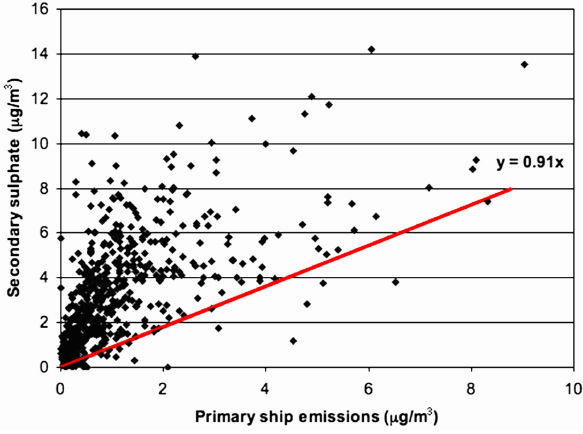
Figure 11. Correlation plot between the contributions from sec- ondary sulfate and from primary particulate emitted by ships as ob- tained by the PMF